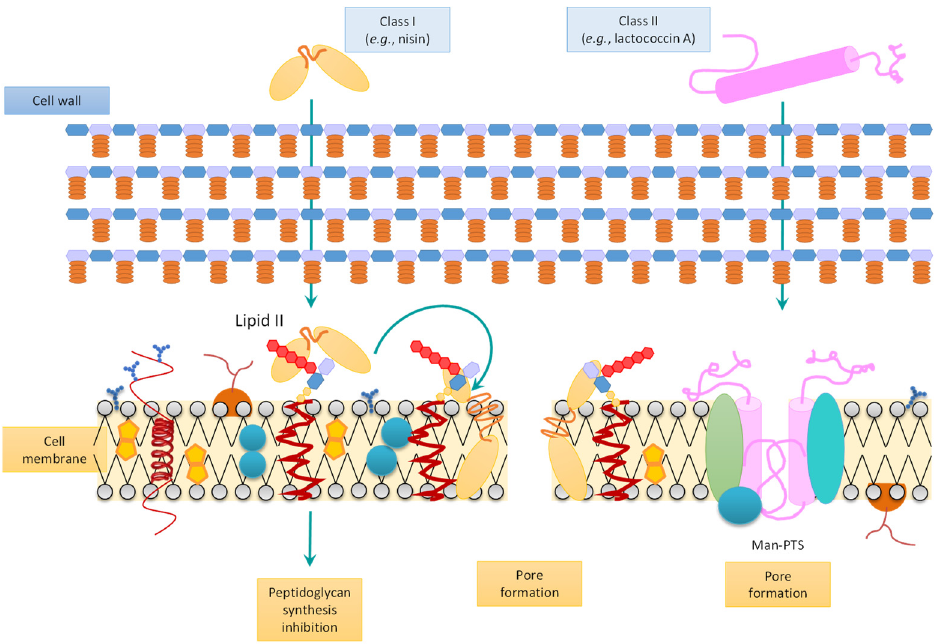
Figure 1. Mechanism of action of bacteriocins on Gram-positive bacteria. Adapted from da Costa et al. [22].